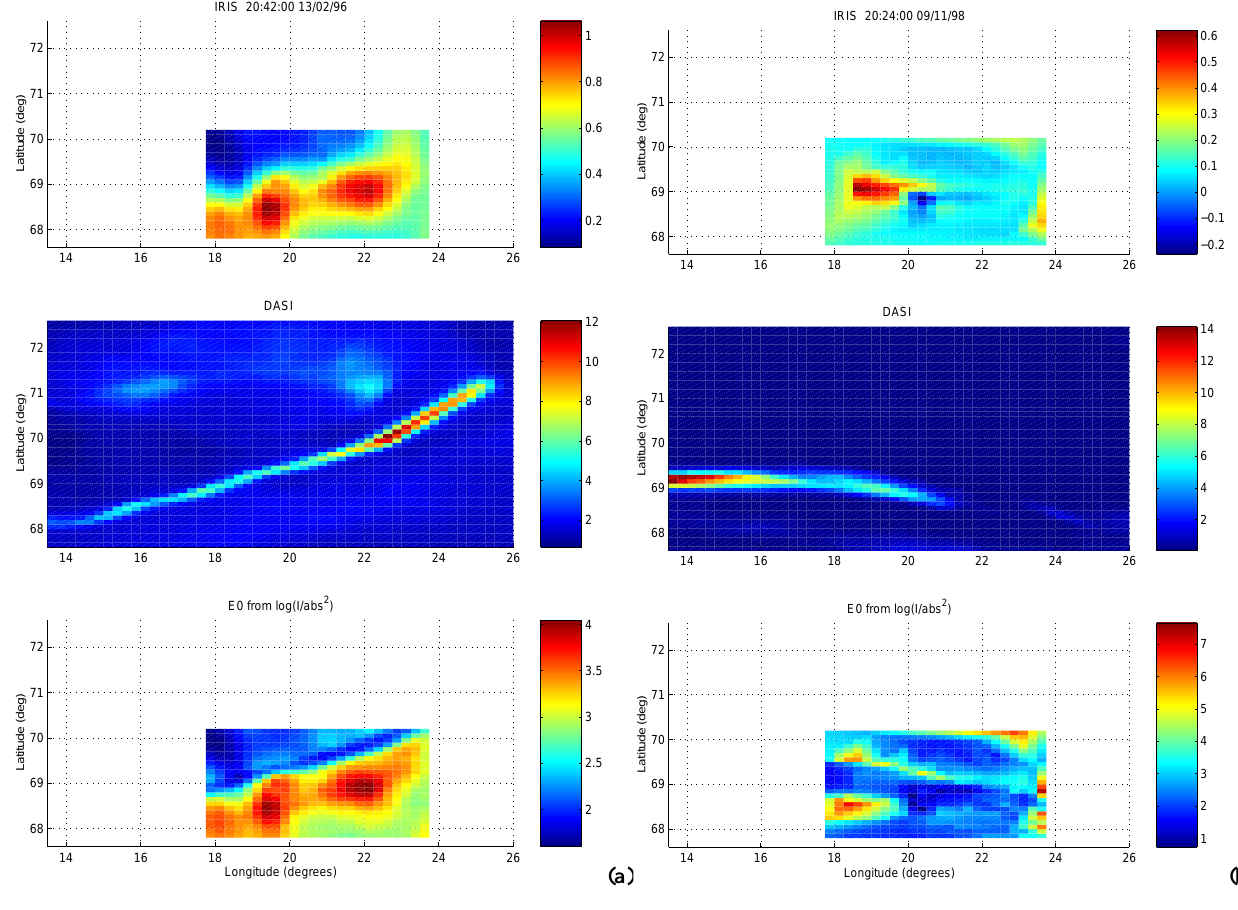
Fig. 7. Energy maps for auroral arcs as seen by IRIS and DASI in their respective fields of view at (a) 20:42UT on 13 Feb 1996 and at (b) 20:24UT on 9 Nov 1998. (Top panels) 2-D absorption distribution, (middle panels) green-light intensity from DASI, and (bottom panels) characteristic energy map in the common field of view of the instruments. The colour bars on the right-hand side are, respectively, in dB (top), in kR (middle), and in keV